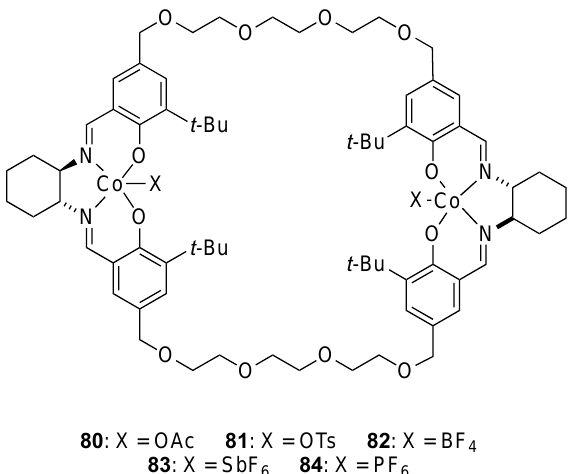
Figure 33. Cyclic bissalen complexes 80 – 84 containing ethylene glycol chains. The counterions (X) are formally illustrated as bound to the metal.